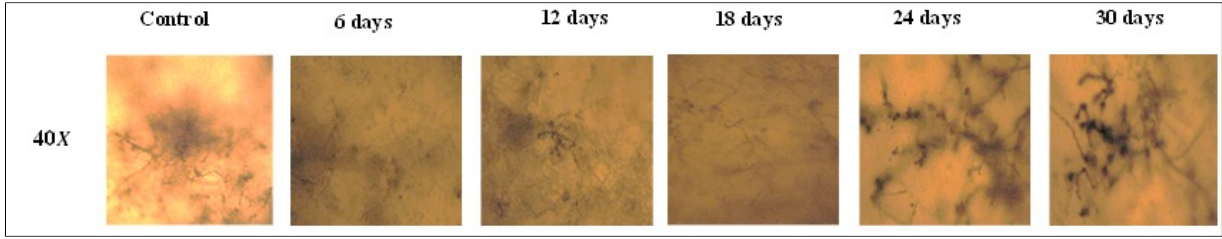
Figure 6. Microscopic images of the CSH of samples during the soil burial test.